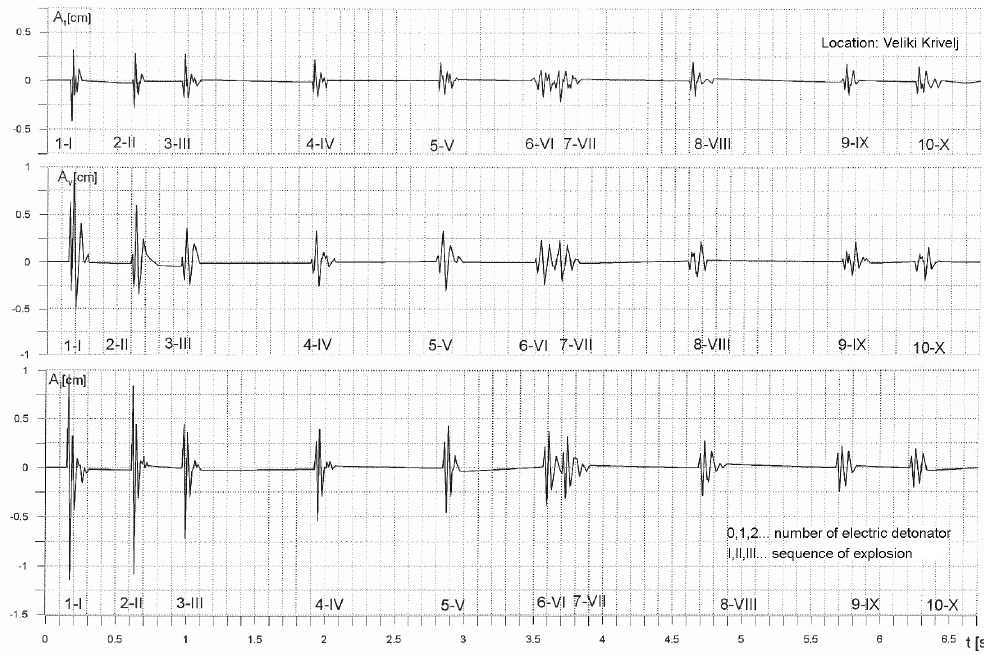
Figure 3. Record of soil oscillation velocity for blasting in the Veliki Krivelj Open Pit.